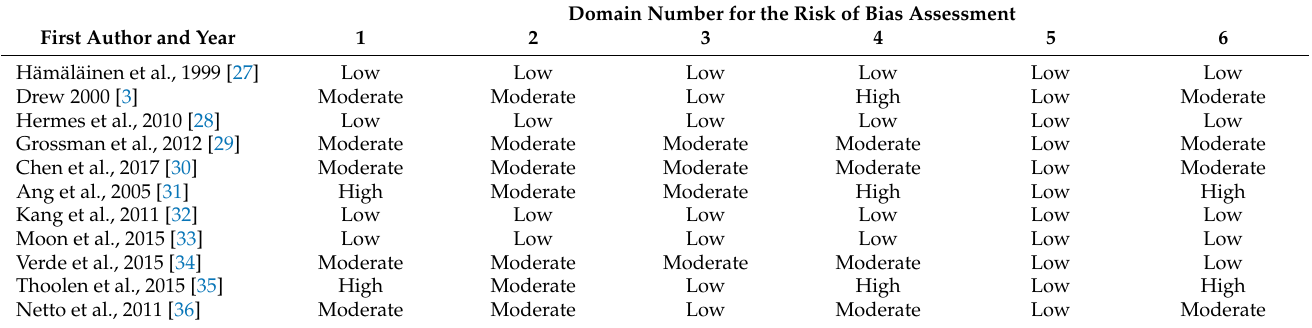
Table 1. Risk of bias assessment for the six domains for each study for the first research question.